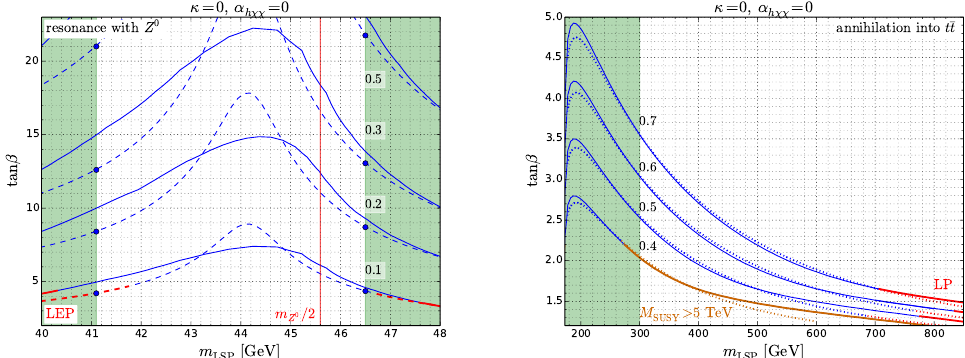
Figure 3 . Contour lines of (cid:10) h 2 = 0 : 12 (obtained with MicrOMEGAs ) as functions of m LSP and tan (cid:12) for a few values of (cid:21) (dashed lines in the left plot was obtained from eq. (3.6) after substituting (3.2) whereas dotted lines in the right plot from eq. (3.7) after substituting (3.2)) for blind spots with decoupled all Higgs particles except the SM-like one. Left plot: green areas and thick red lines denote the points excluded by LUX and the LEP chargino searches, respectively; thick blue points correspond to eq. (3.10) and (3.11). Right plot: green region and thick orange line depict the points excluded by LUX and points for which the stop masses above 5 TeV are necessary to obtain the correct Higgs mass (even when the contribution from the stop mixing is maximized), respectively. The red lines denoted by LP depict regions with a Landau pole below the GUT